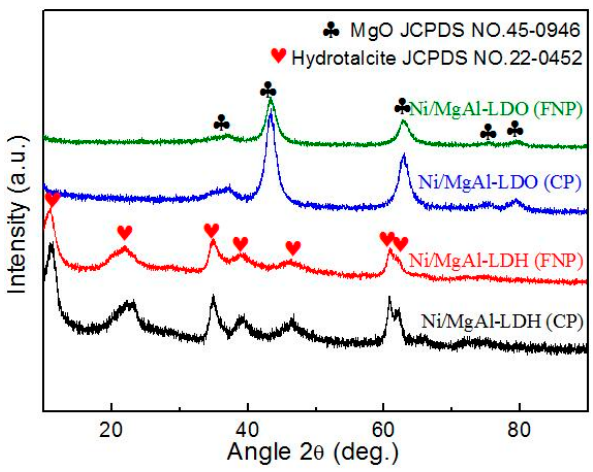
Figure 6. XRD patterns of Ni/MgAl-LDH (CP), Ni/MgAl-LDH (FNP), Ni/MgAl-LDO (CP), and Ni/MgAl-LDO (FNP).